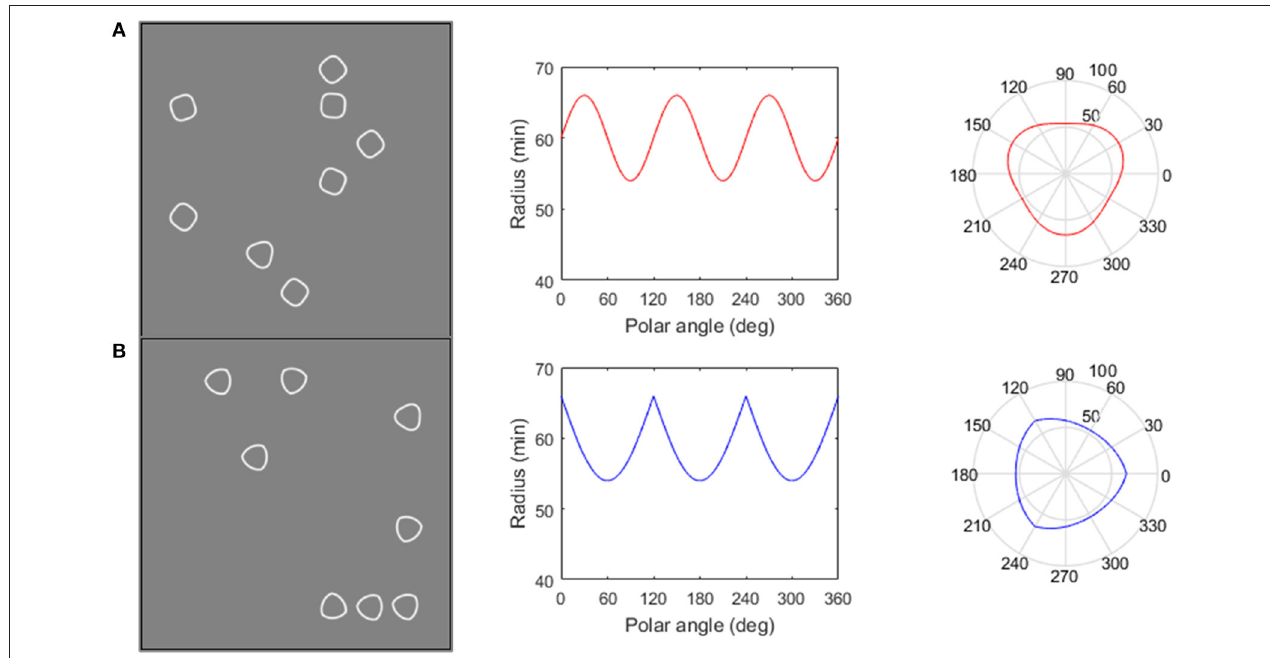
FIGURE 1 | The Global (A) and Local (B) RFST. Global RFST, (A) , column 1: participants must find an RF3 (soft-edged triangle) target amongst RF4 (smooth-cornered squares) distractors, known to be globally processed (47). Local RFST (B) , column 1: target and distractors are matched on global descriptors (both RF3s), and are only distinguishable by local differences in curvature or orientation. Column 2 describes how the radii change with variations in polar angle. (A) Displays a conventional RF pattern with 3 cycles of modulation (denoted RF3), whereas (B) represents a negatively rectified sinusoid. This negative rectification creates curvature discontinuities which manifest as sharp as opposed to smooth corners (see column 3); however, both patterns contain the same number of points of maximum